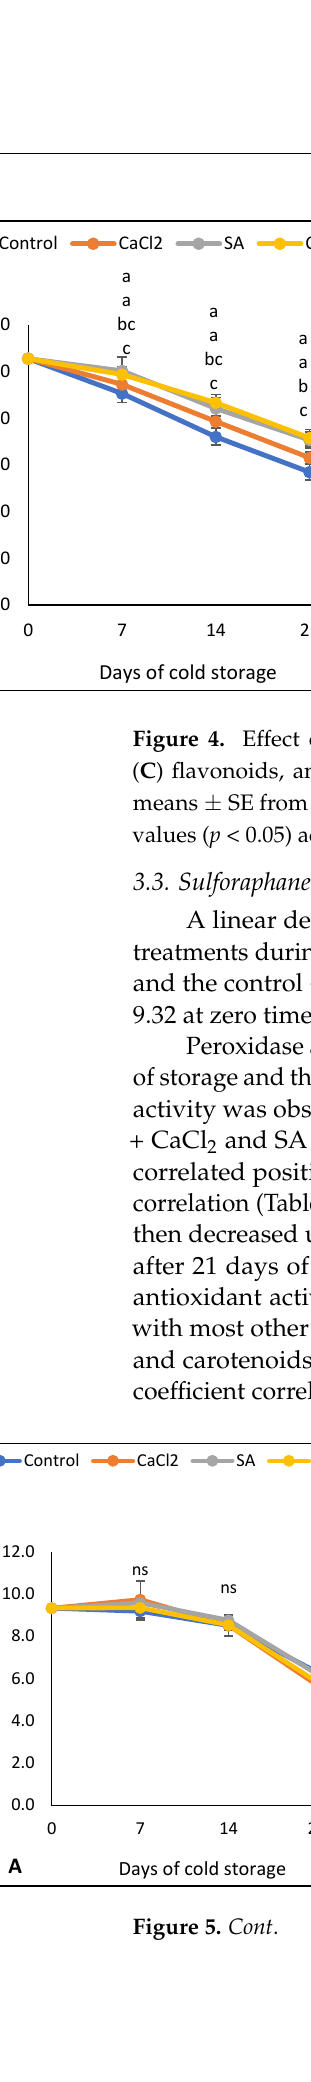
Figure 5. Effect of SA and CaCl 2 and their combination on ( A ) sulforaphane, ( B ) peroxidase activity, and ( C ) antioxidant activity of broccoli florets stored at 5 °C for 28 days. Values are means ± SE from three replicates ( n = 3). Same letter means no significant differences between the values ( p < 0.05) according to Duncan test.